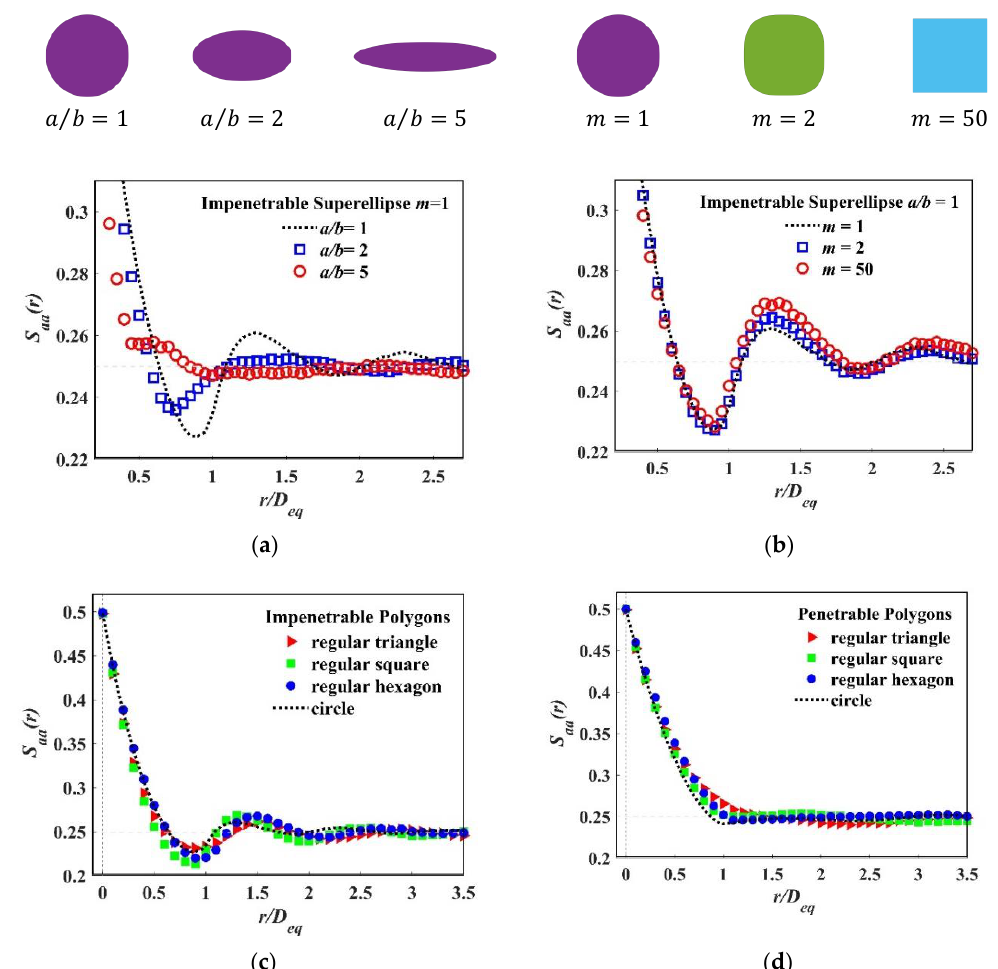
Figure 8. 𝑆 𝑎𝑎 (𝑟) of different particle shapes: ( a ) Selected aspect ratio 𝜅 from 1 to 5; ( b ) Selected shape parameter 𝑚 from 1 to 50; ( c ) Selected regular polygons, from triangle to circle, which can be treated as a polygon with infinite sides; ( d ) Selected penetrable models: from triangle to circle.